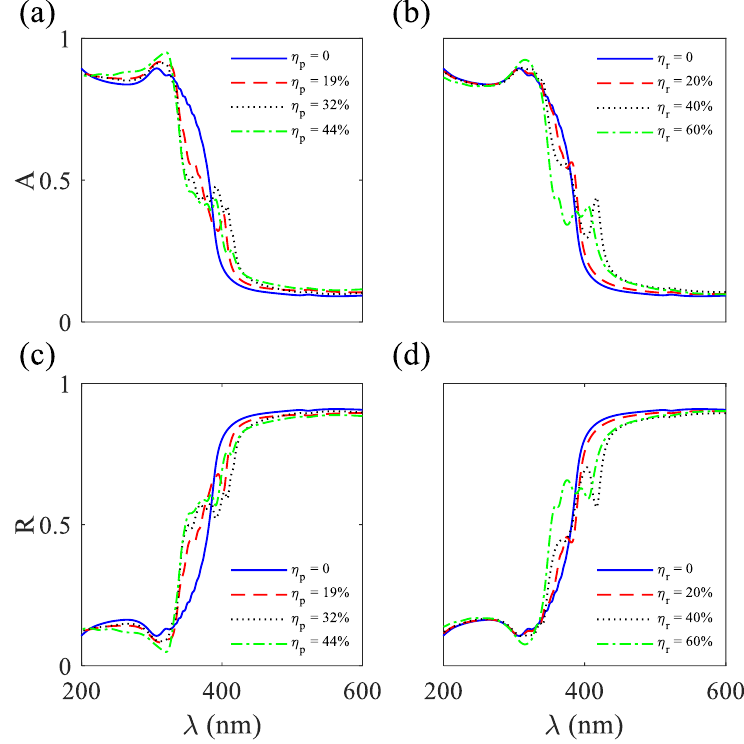
Figure 4. Absorption (A) spectra for 2D MPHCs consist of 15 × 15 Ag rods in air under TM polarized illu- minations under ( a ) position and ( b ) radius disorderings. Reflection (R) spectra of the 2D MPHCs consisting 15 × 15 Ag rods in air under TM polarized illuminations under ( c ) position and ( d ) radius